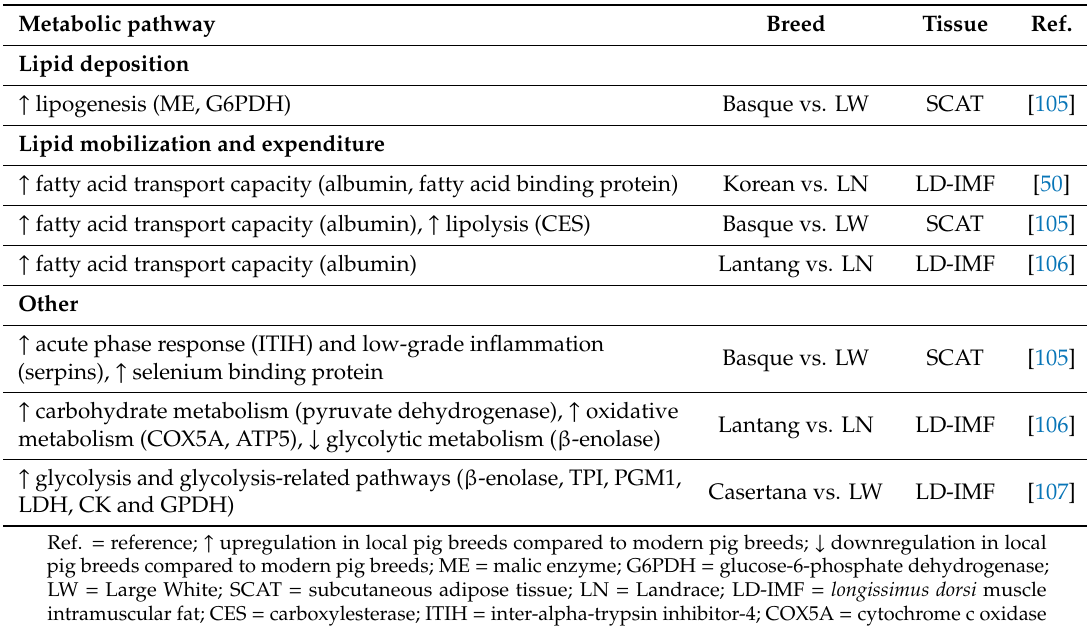
Table 5. Summary of comparative proteomics studies with the main findings between local and modern pig breeds associated with fat